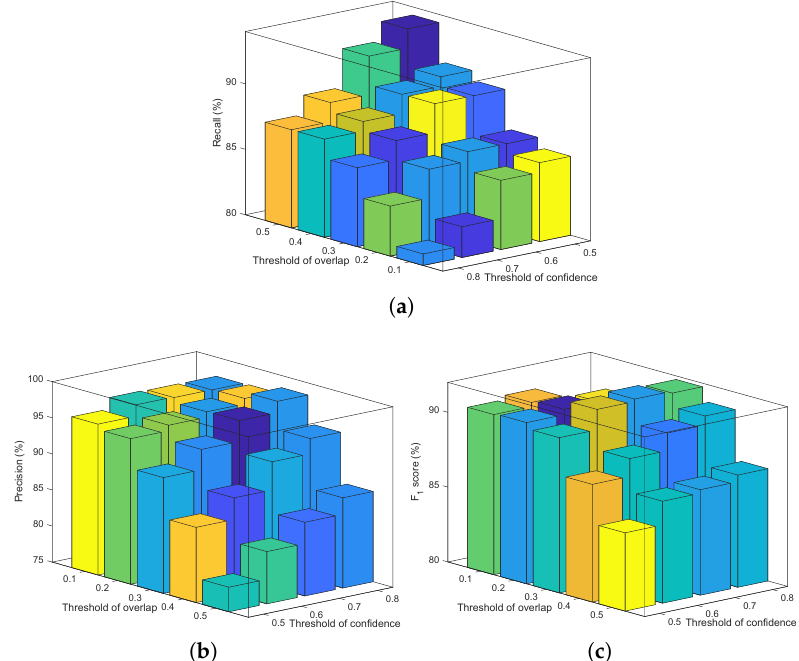
Figure 13. The effect of different overlap and confidence thresholds on ( a ) recall, ( b ) precision, and ( c ) the F 1